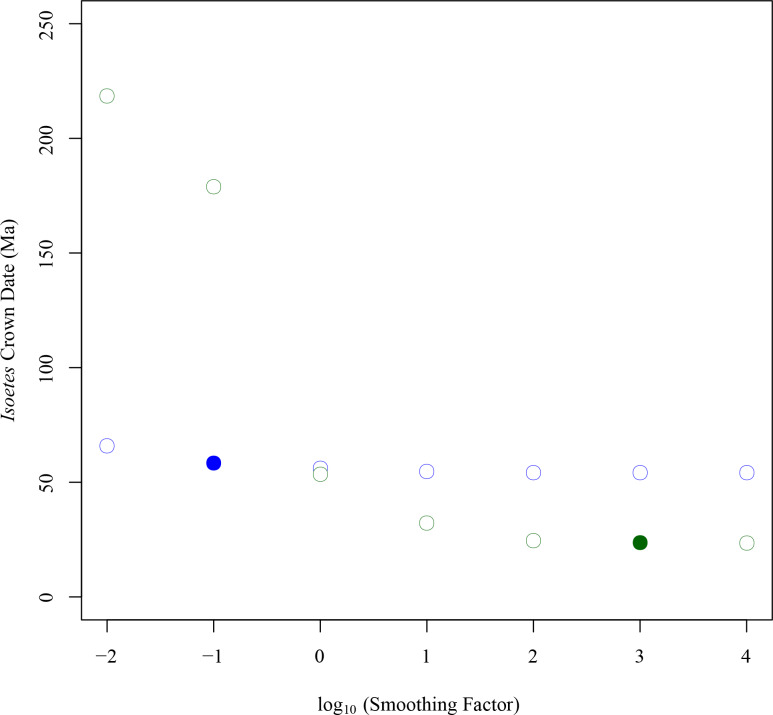
Effect of different smoothing factors on Isoetes crown date estimation in r8s.Estimated crown dates for Isoetes produced by r8s for concatenated chloroplast (green) and nuclear (blue) datasets are shown for a range of smoothing factors. The best fitting smoothing factor, as identified by cross validation, is highlighted for each dataset by a filled circle.